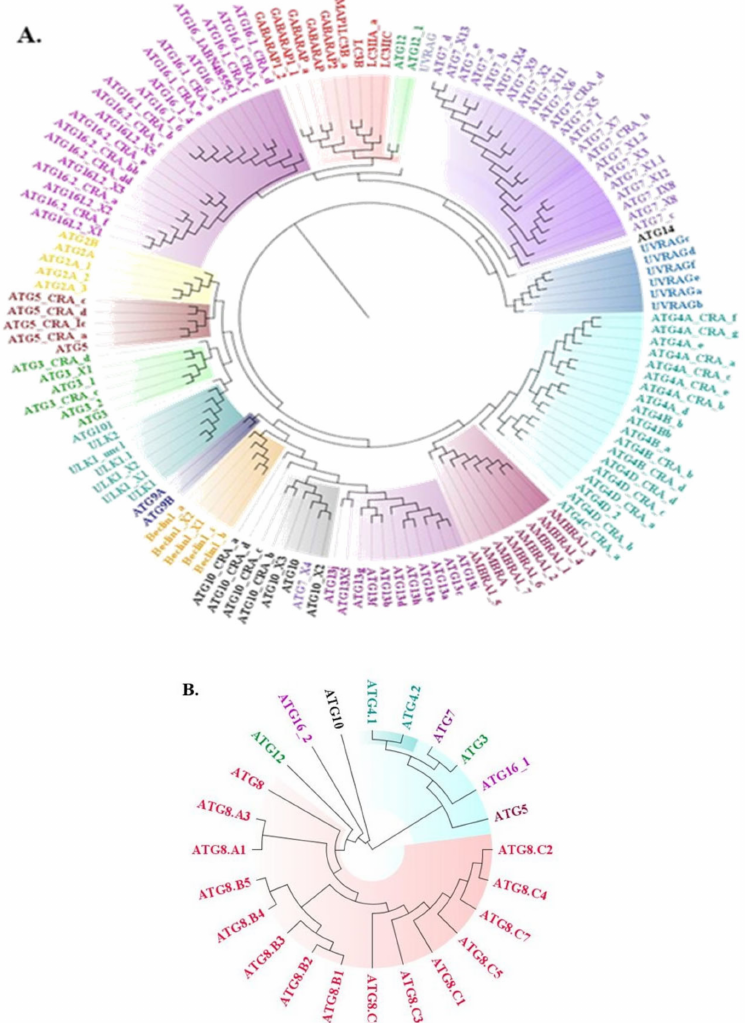
Figure 1. Phylogenetic tree illustrating evolutionary conservation across ATG proteins; different color keys indicate different types of ATG proteins. ( A ) Phylogenetic tree of Homo sapiens ( B ) Phylogenetic tree of Leishmania major